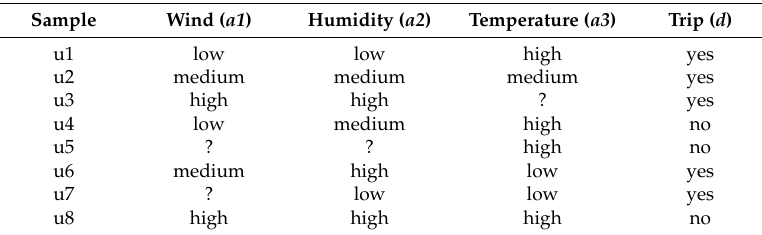
Table 9. Example table with missing